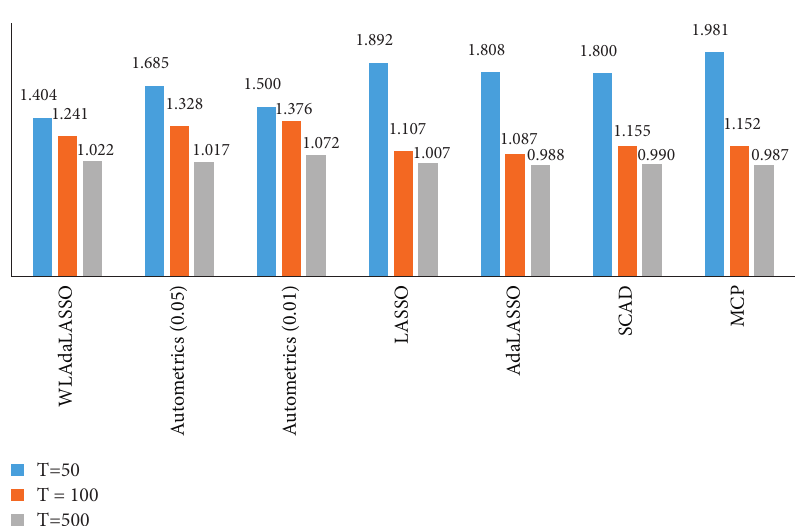
Figure 2: Simulated result of RMSE with ϕ equal to